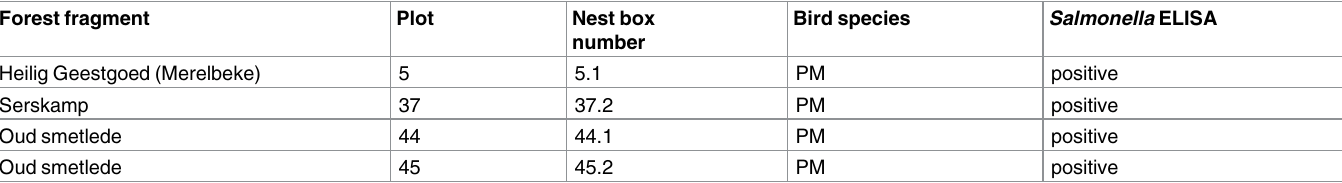
Table 2. IgY antibody assessment in blood of great tits. Indicated are fledglingshaving anti- Salmonella antibodies(IgY) in their blood at day 14–15. Forest fragment Plot Nest box Bird species Salmonella number